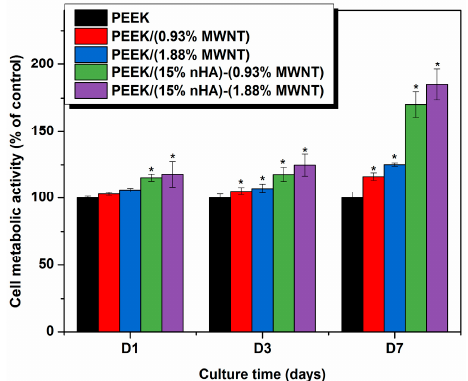
Figure 13. 2-(4-Iodophenyl)-3-(4-nitrophenyl)-5-(2,4-disulfophenyl)-2 H -tetrazolium (WST-1) assay results showing cell metabolic activity of murine MC3T3-E1 pre-osteoblasts grown on PEEK and its nanocomposites for 1, 3 and 7 days. * represents p < 0.05. Significance is assessed for each time-point assayed.